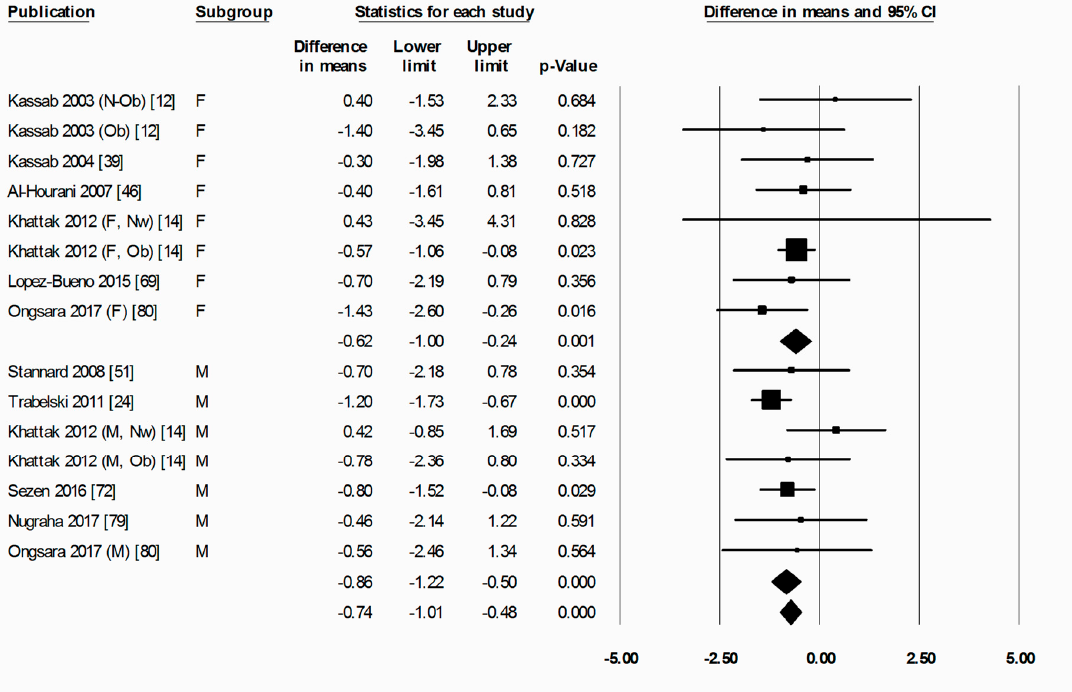
Figure 4. Fat percentage was significantly decreased by Ramadan fasting in both the female and the male subgroup. Change in fat percentage (%) as subdivided by sex (female and male), between pre-Ramadan (pre-R) and the end of Ramadan (post-R). There was no significant difference between female and male subgroups ( p = 0.375). Heterogeneity statistics: female T = 0.000, p = 0.771, I 2 = 0.0%; male T = 0.000, p = 0.435, I 2 = 0.0%. F = female; M = male; Nw = normal weight; Ob = obese; N-Ob = non-obese.